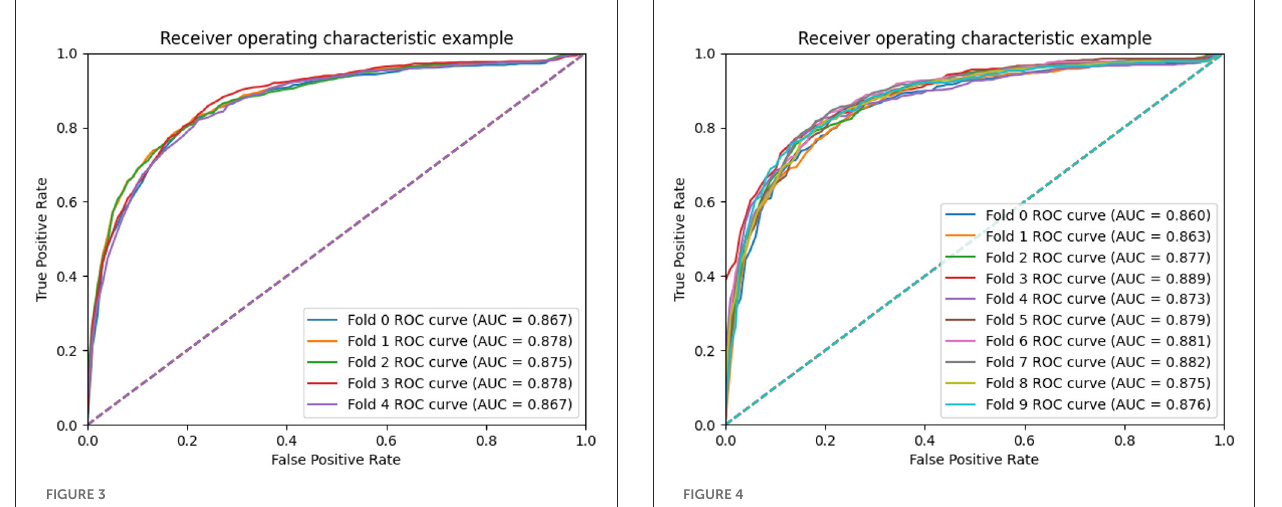
FIGURE3 AUC performance of GCNA-MDA model on 5-fold cross-validation.